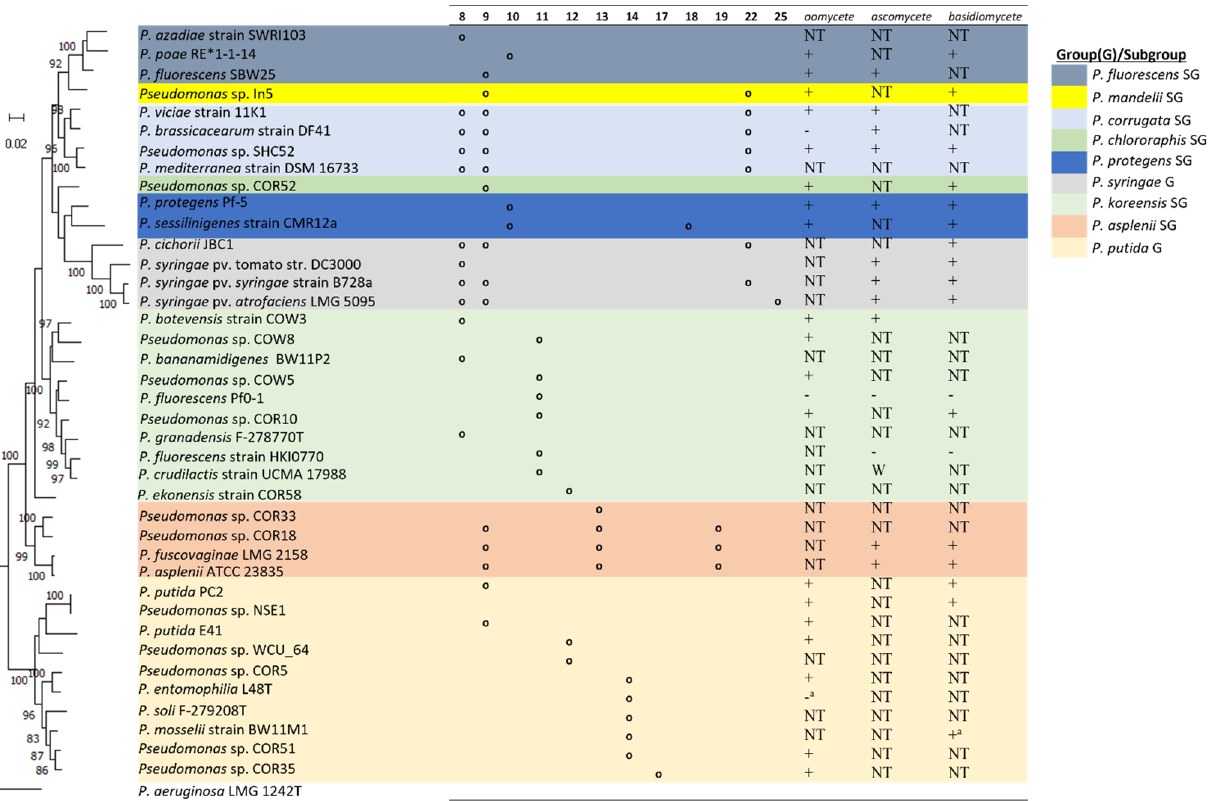
Figure 5. Comparison of Lipopeptide Amino Acid (AA) Composition and In Vitro Biological Activity within the Pseudomonas Genus. Within each group/subgroups, representative strains producing unique LPs with available genomes on NCBI were selected. Sequences of 16S rRNA and housekeeping genes ( gyrB , rpoB and rpoD ) were used; maximum likelihood tree, GTR+G+I model (MEGA-X) [115]. Bootstrap values were calculated based on 1000 replications. P. aeruginosa was used as an outgroup. Strains within the P. fluorescens , P. chlororaphis , P. protegens , P. koreensis , and P. putida (sub)groups have single LPs with 8, 9, 10, 11, 12, 14 or 17AA. An exception is strain CMR12a ( P. protegens SG) which produces two LPs (10 and 18AA). Multiple LPs are produced by strains affiliated with the P. mandelii (9 and 22AA), P. corrugata SG (8, 9 and 22AA), P. syringae G (8, 9, and 22/25 AA) and P. asplenii SG (8, 13, and 19AA). Biological activity conducted in in vitro tests using purified compounds are shown. +: LP active; -: LP inactive; NT: LP not tested; - a : LP mutant tested.